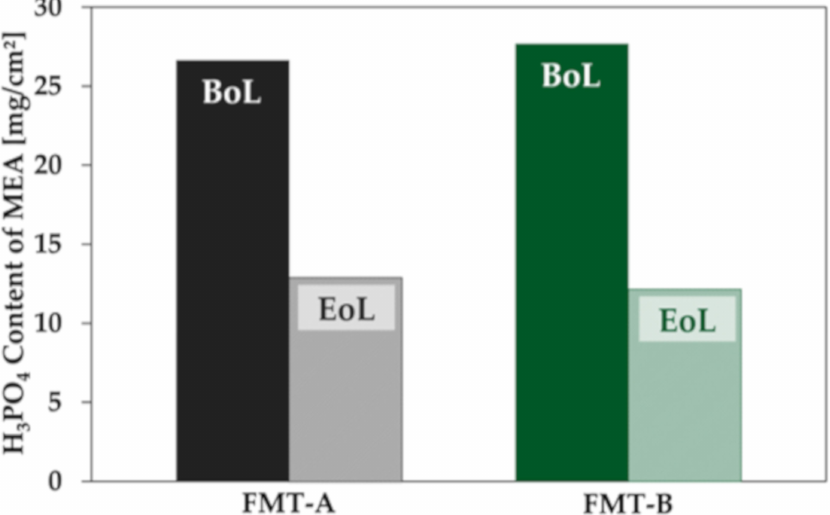
Figure 5. H 3 PO 4 content of FMT-A and B before (BoL) and after long-term test (EoL) at 0.3 A / cm 2